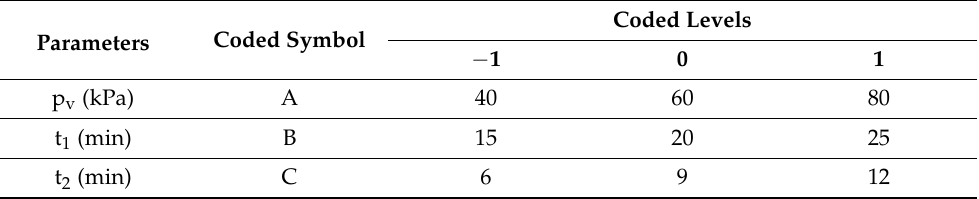
Table 2. Coded values of the treatment variables for all VI solutes employed. Parameters Coded Symbol